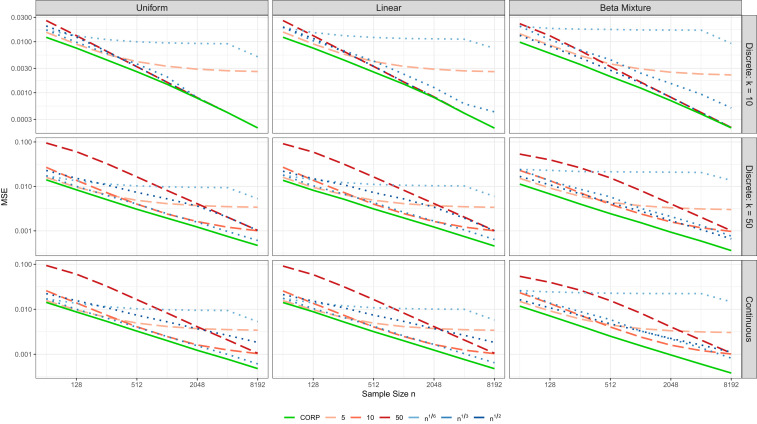
MSE of the CEP estimates in CORP reliability diagrams for samples of size n, in comparison to the binning and counting approach with m=5, 10, or 50 fixed bins, or m(n)=[nα] quantile-based bins, where α=16, 13, or 12. Note the log–log scale. The simulation settings are described in Appendix A, and MSE values are averaged over 1,000 replicates.